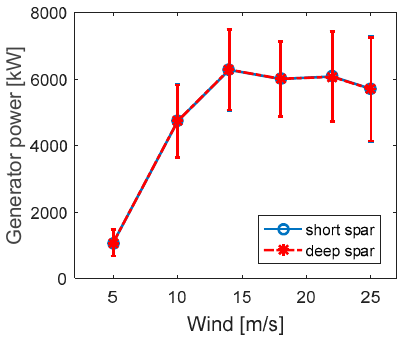
Figure 8. Mean power production for the short spar VAWT and deep spar VAWT with error bar representing the standard